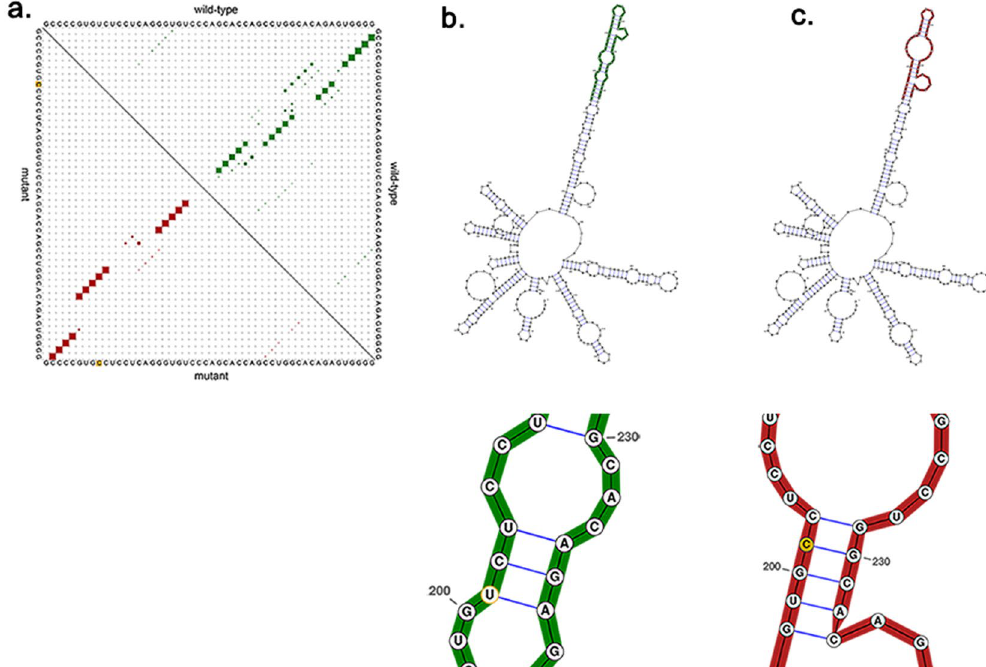
Figure 3. The predicting rs10132552 on MEG3 secondary structure. ( a ) Base pair probabilities of the local region rs10132552. ( b ) The optimal secondary structure of global wild-type sequence. Minimum free energy − 150.60 kcal/mol. ( c) The optimal secondary structure of global mutant sequence. Minimum free energy − 153.30